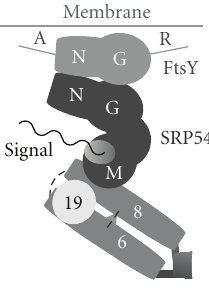
Figure 4: Interactions between the components of archaea SRP- mediated protein targeting. Schematic drawing of the coaxially- arranged SRP RNA helices 6 and 8 bound together by SRP19 and two tertiary interactions (dashed lines). The M-domain of the SRP54 protein (dark gray) binds to SRP RNA helix 8 as well as the signal sequence (black). The NG-domains of SRP54 and the FtsY SRP receptor are arranged quasisymmetrically and poised to separate upon the hydrolysis of two G-domain-bound GTP molecules. The N-terminal region labeled A (for acidic) and the C- terminal repeat region (R) of FtsY are variable or may be absent (see Table